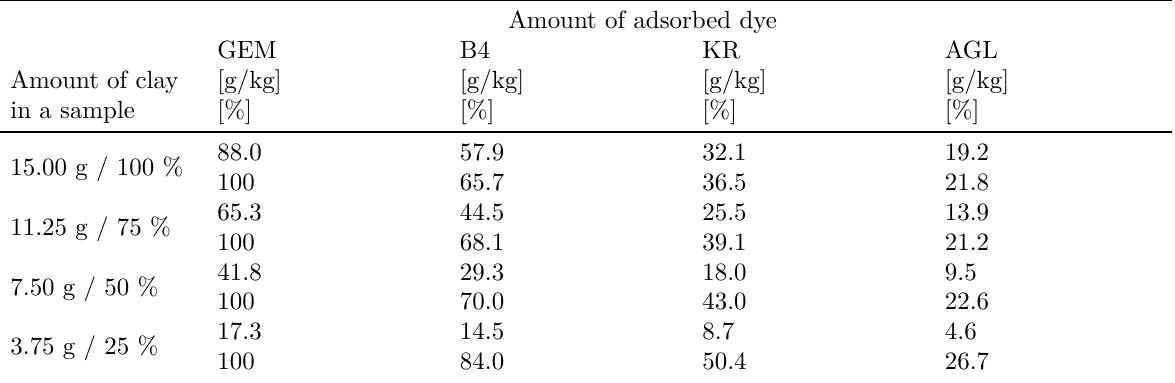
Table 4. Comparison of the amount of adsorbed